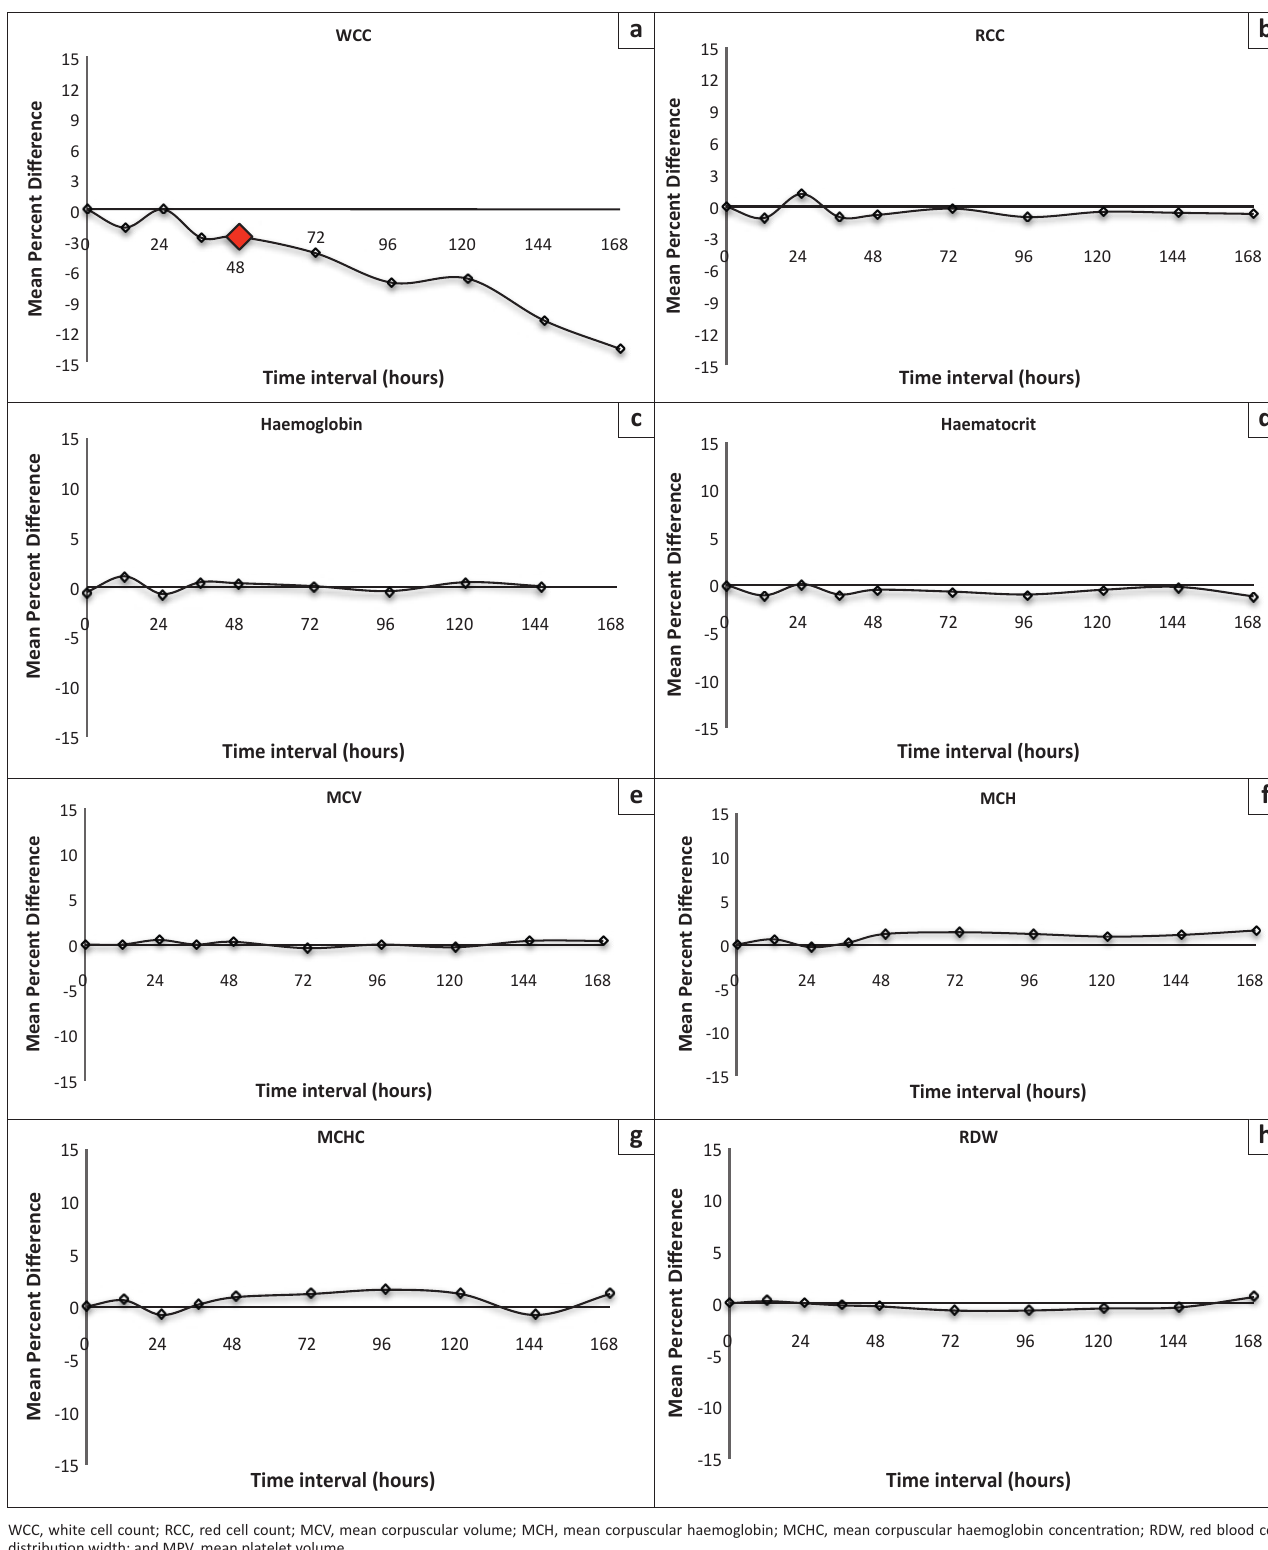
FIGURE 2: Stability analysis (mean percent difference) at 4 °C – 8